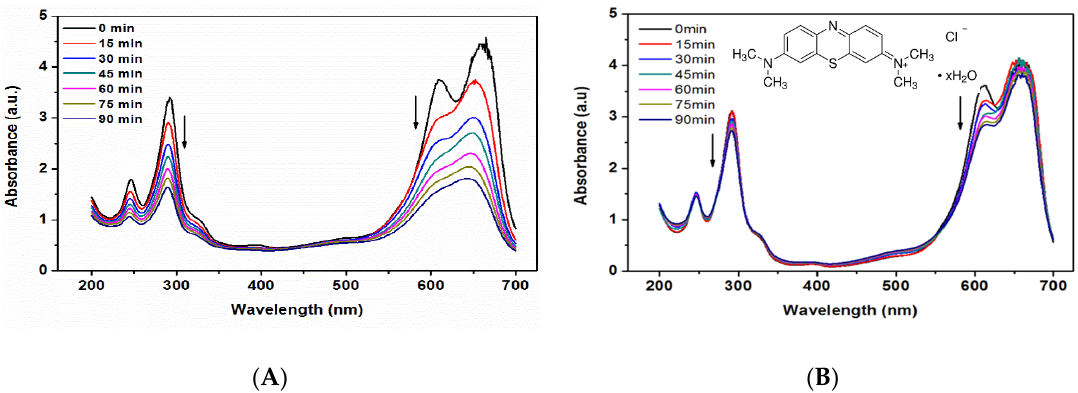
Figure 7. Absorption spectra of methylene blue (MB) ( A ) in the presence and ( B ) in the absence of CdS nanoparticle suspension, both recorded during the irradiation with mercury quartz lamp.